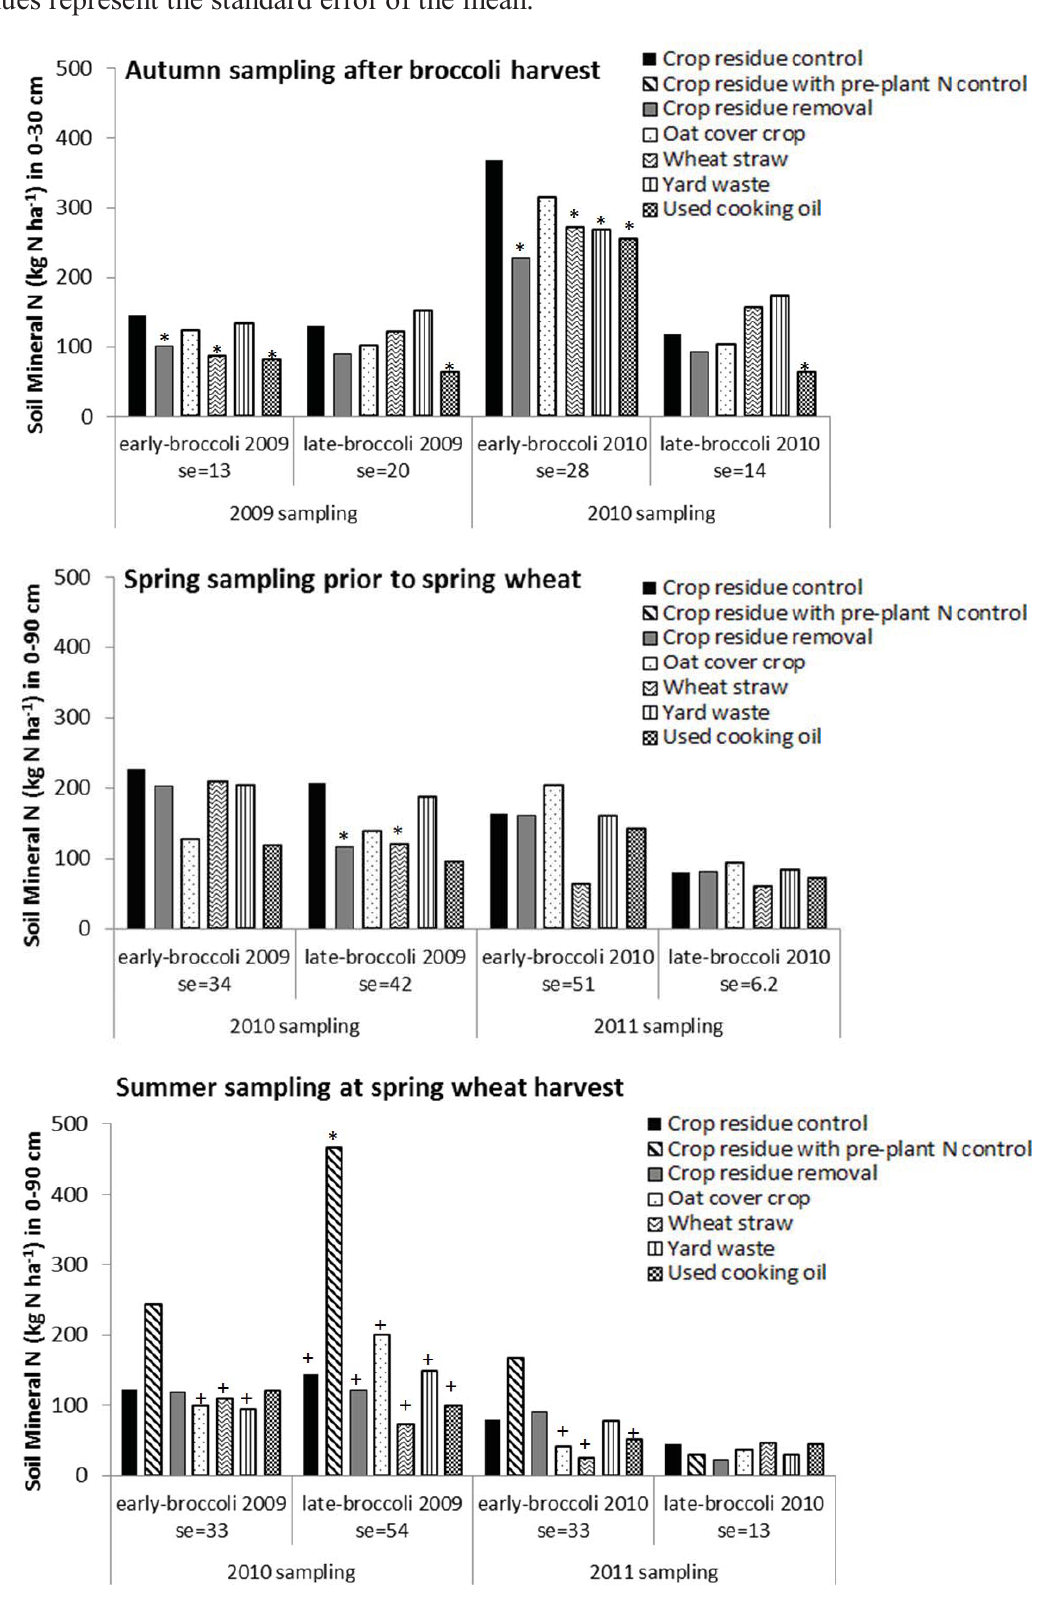
Figure 1. Soil mineral N concentrations in the autumn, spring, and summer after the 2009 and 2010 early- and late-broccoli harvest treatments. Symbols denote a significant difference ( P < 0.05) compared to the crop residue control * or the crop residue with pre-plant N control +, based on a multiple means comparison with a Dunnett-Hsu adjustment. The se values represent the standard error of the